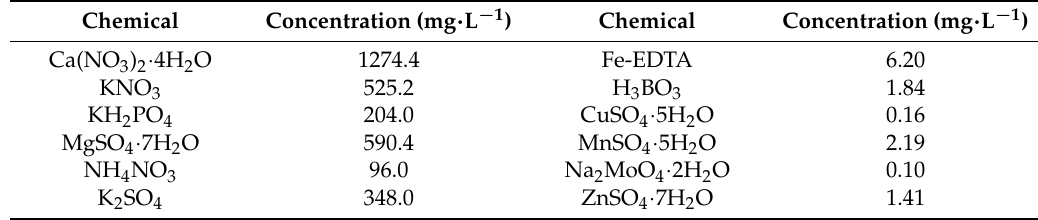
Table 1. The composition of the nutrient solution used in the experiment.